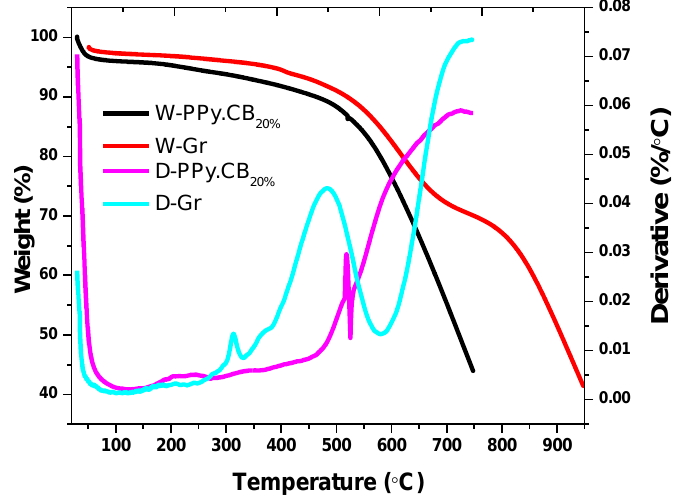
Figure 4. Temperature of analysis of Gr and PPy.CB 20% . ( a ) W-PPy.CB 20% and W-Gr are the per- centage weight curves. ( b ) D-PPy.CB 20% and D-Gr are the derivatives curves.